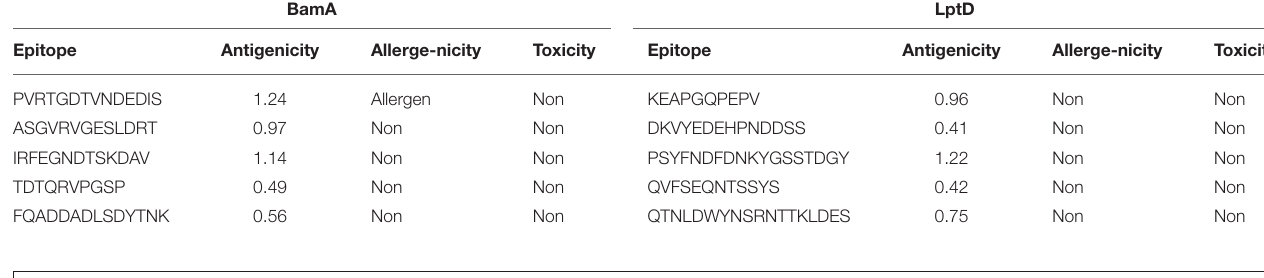
TABLE 3 | Predicted B-cell epitopes of BamA and LptD proteins.